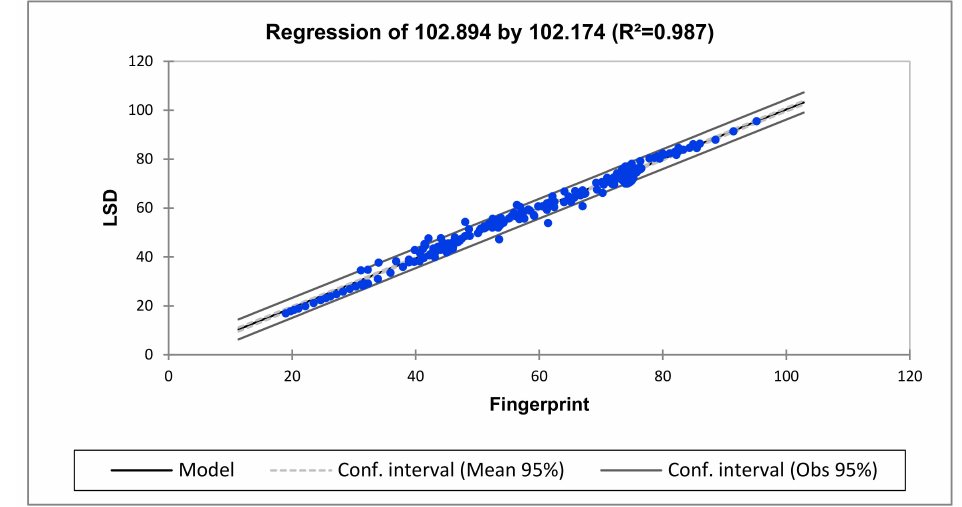
Figure 11. Regression analysis for fingerprint vs. after deformation (medium-frequency region).